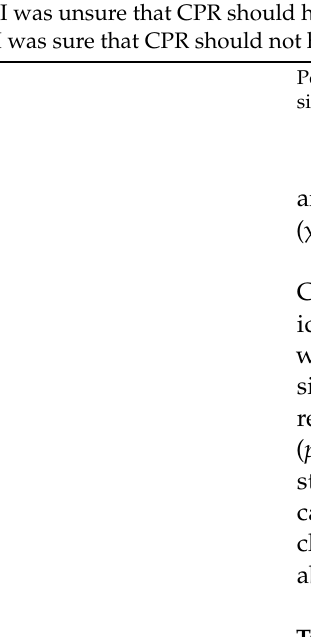
Table 7. Logistic regression regarding the perception of the need to start resuscitation vs. variables dependent on the